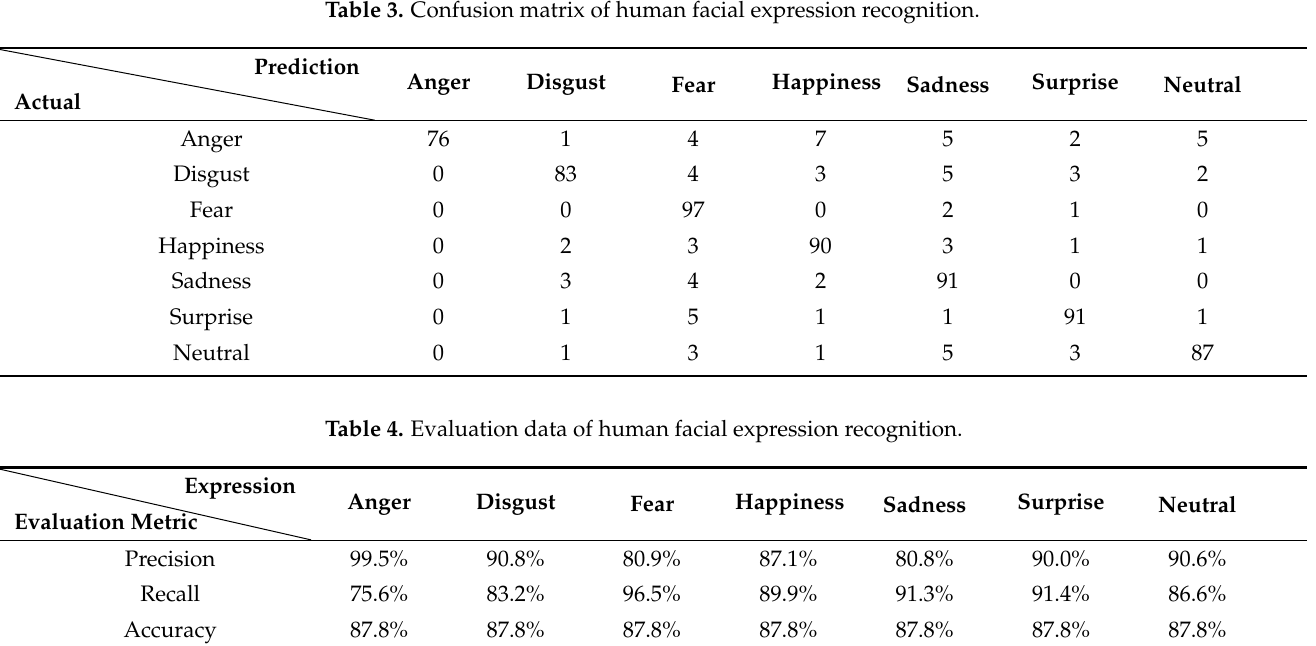
Table 3. Confusion matrix of human facial expression recognition.